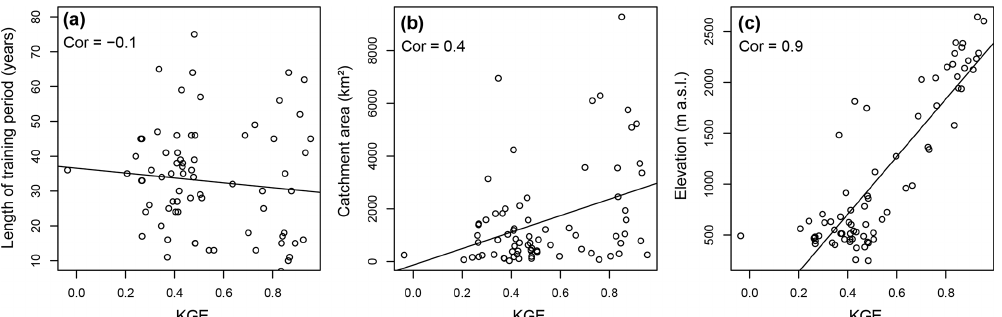
Figure B1. Relationship between model performance and catchment characteristics, including (a) record length used to fit the GAM, (b) catchment area, and (c)